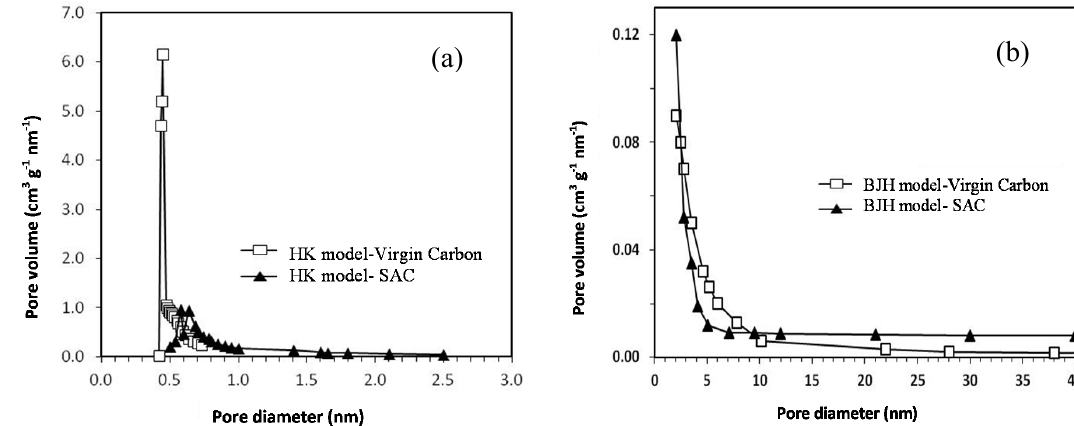
Figure A3. Pore diameter of virgin carbon and SAC calculated using the ( a ) Horvath, Kawazoe (HK) model and ( b ) Barrett, Joyner, Halenda (BJH) model.